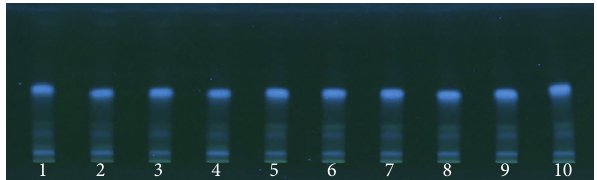
Figure 5: Developed TLC plate of V. anthelmintica under UV